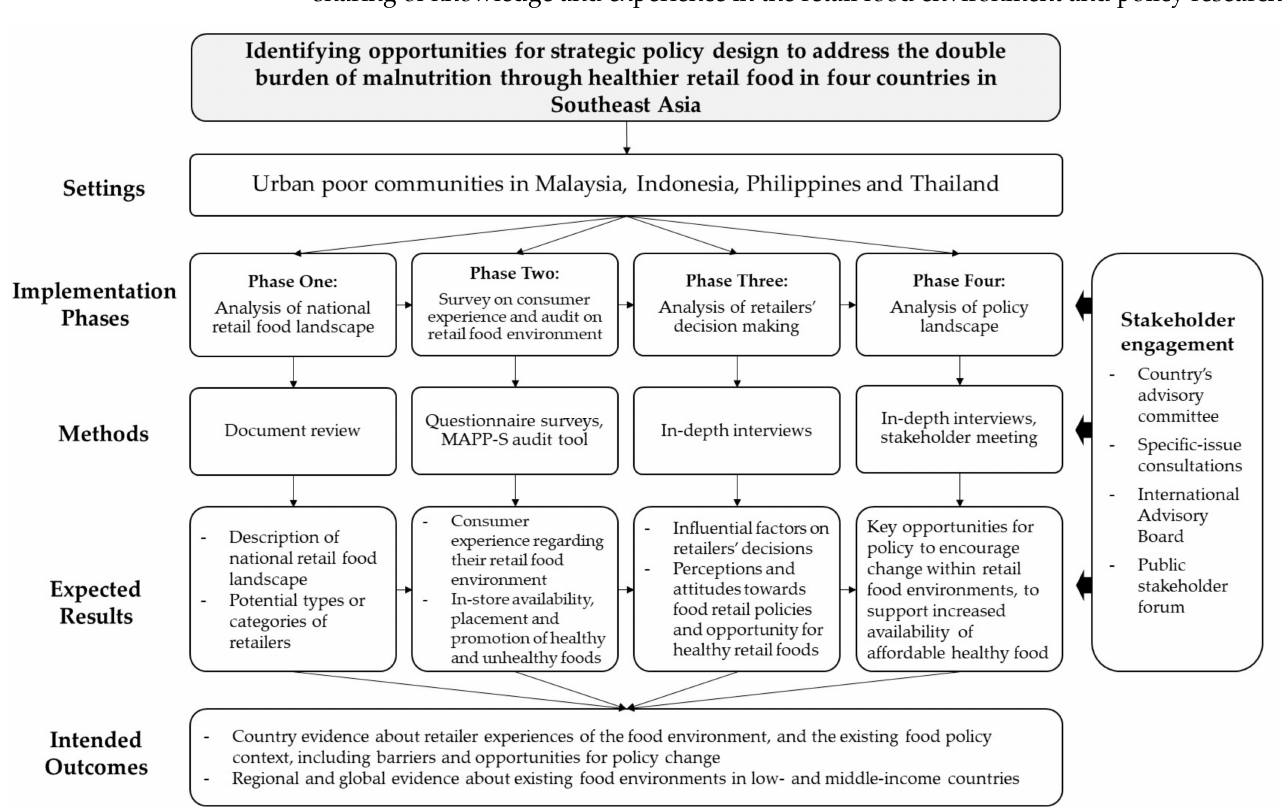
Figure 1. Schematic presentation of the SEAOFE study